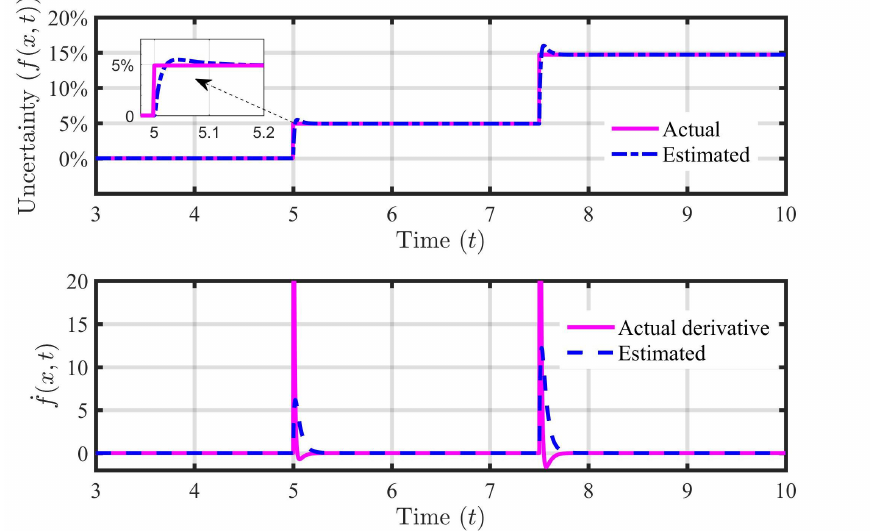
Figure 7. DESO − based estimation of disturbance due to parametric uncertainties and its first-order